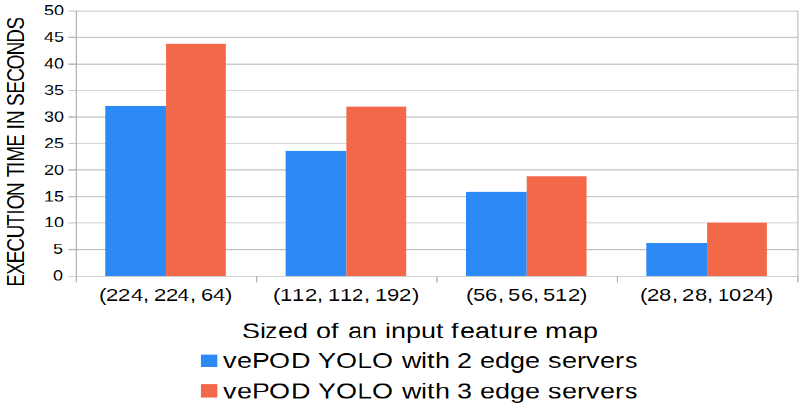
Figure 9. Execution time of the secure max pooling in vePOD YOLO with two and three edge servers.